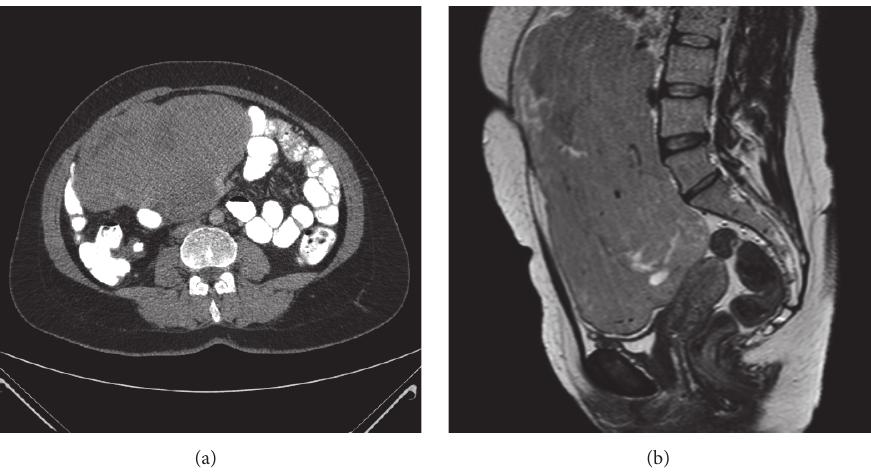
Figure 1: Computerized tomography (a) and magnetic resonance imaging (b) showing a solid, multiloculated, and hypervascular mass starting from the pelvis and extending to the transverse colon, 26 × 22 × 16cm in size.